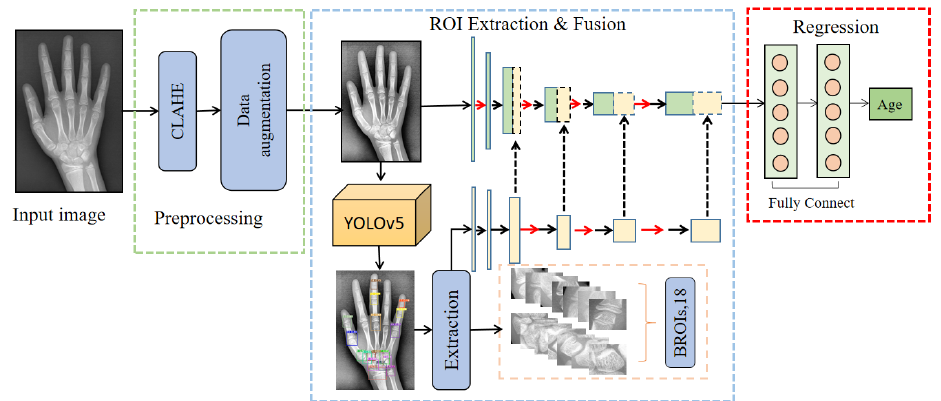
Figure 4. The overall process framework. It contains three major parts: (1) data preprocessing; (2) ROI extraction and feature fusion; (3) bone age